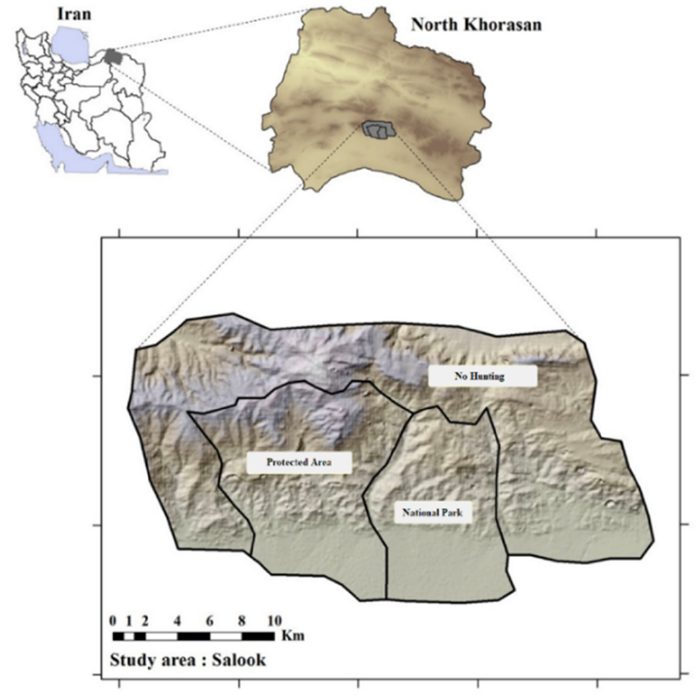
Figure 1. The location of the study area.